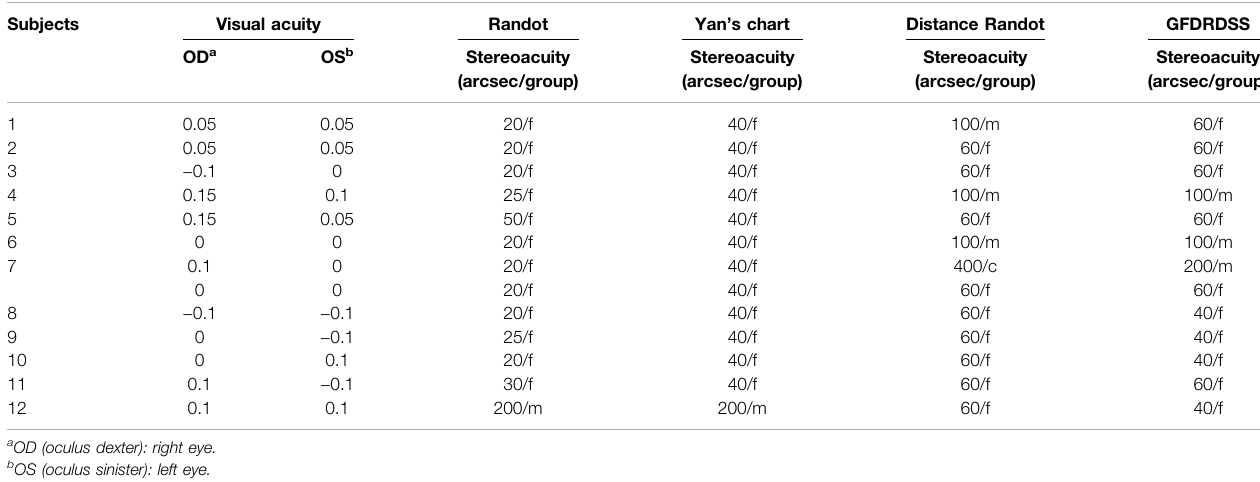
TABLE 3 | The stereoacuity of 12 subjects examined by four stereotests.